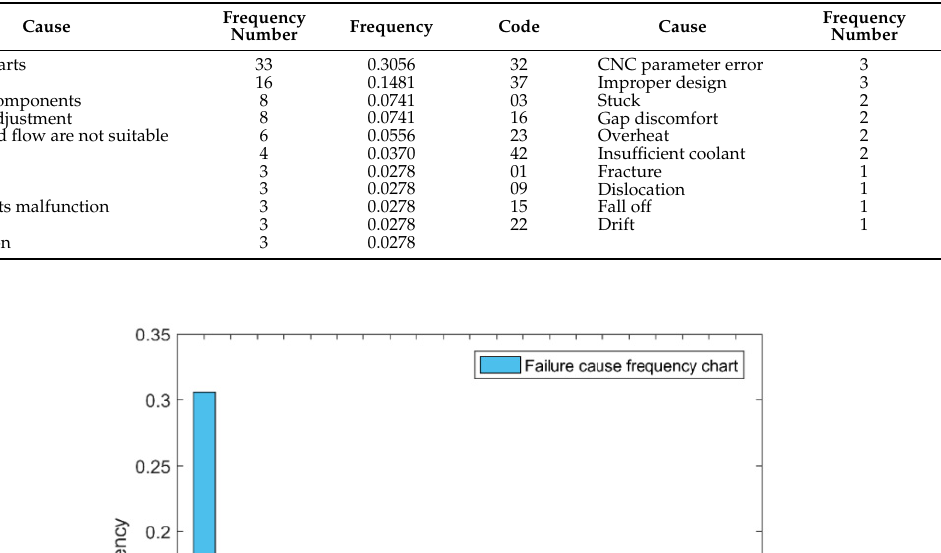
Table 3. Frequency table of failure cause of the machining center.